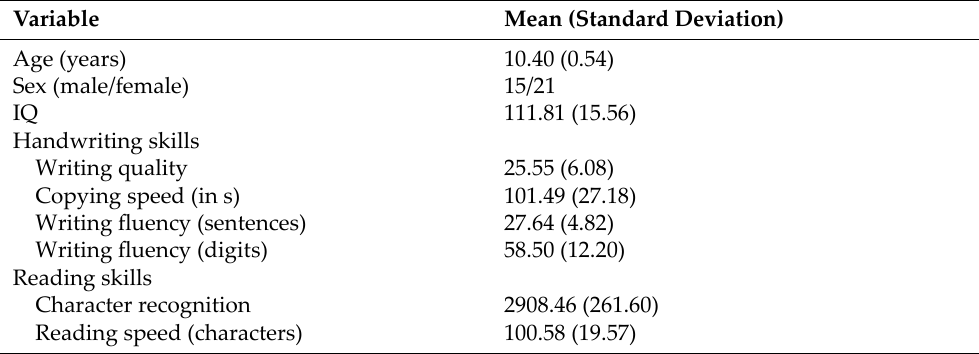
Table 1. Demographic information and behavioral task